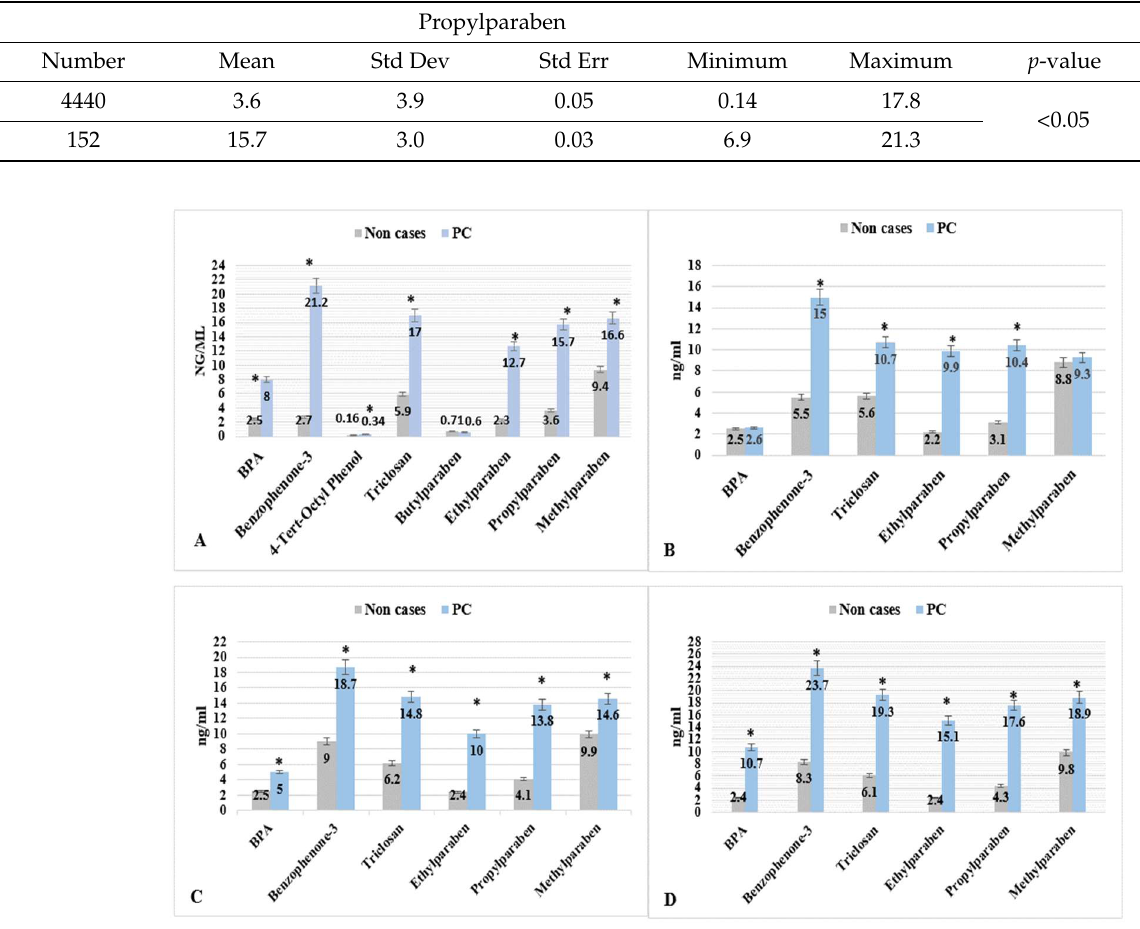
Table 4. Age, weight, and lipid profile levels (mg/dL) in the male population; NHANES 2005– 2015.